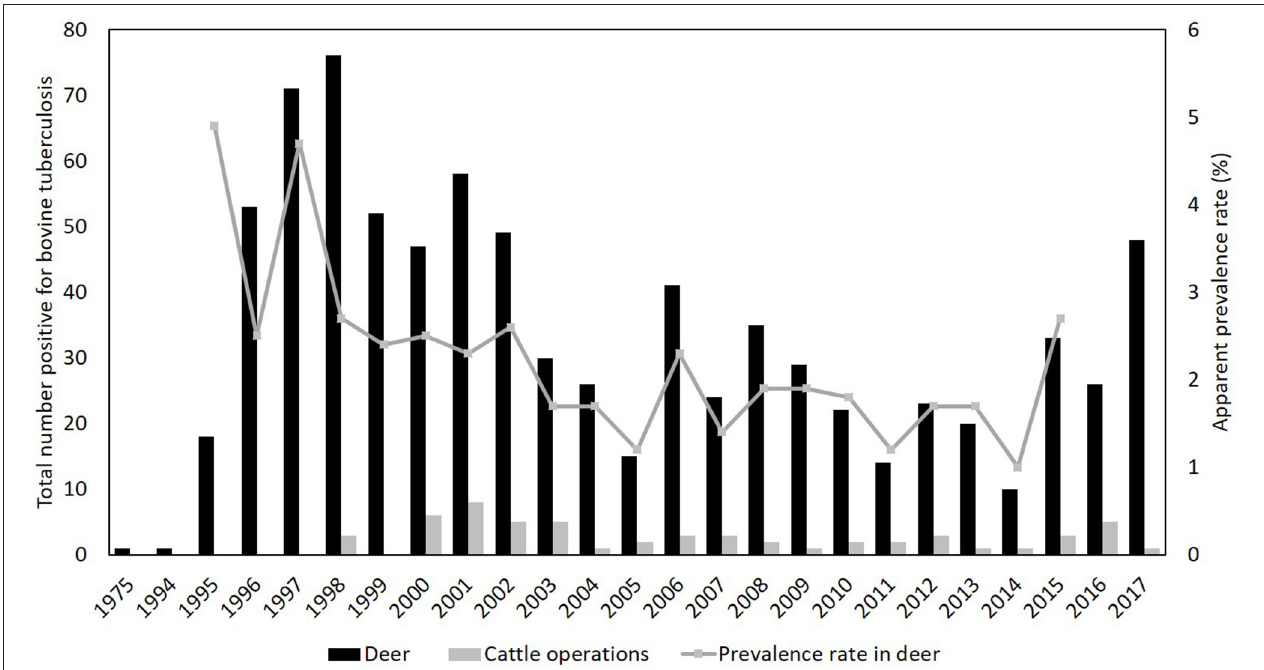
FIGURE 2 | Apparent prevalence rates in white-tailed deer ( Odocoileus virginianus ) as well as numbers of cattle operations and white-tailed deer confirmed positive for infection with Mycobacterium bovis